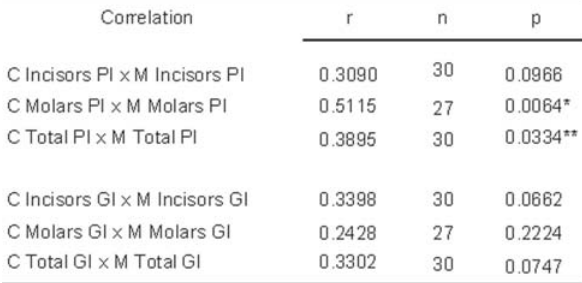
TABLE 2- Pearson’s correlation between the variables incisors, molars and total teeth considering the plaque (PI) and gingival indexes (GI) of children (C) and mothers